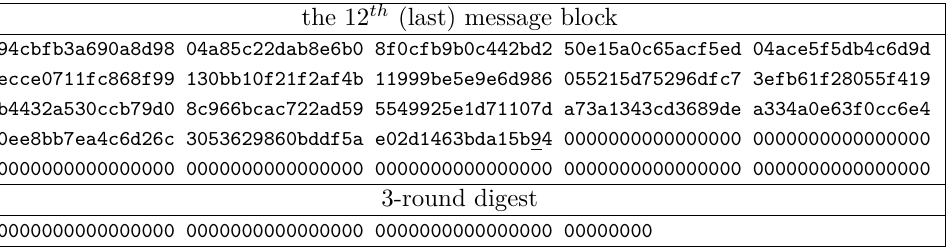
Table 7: The last message block and the 3-round digest (in little-endian order).